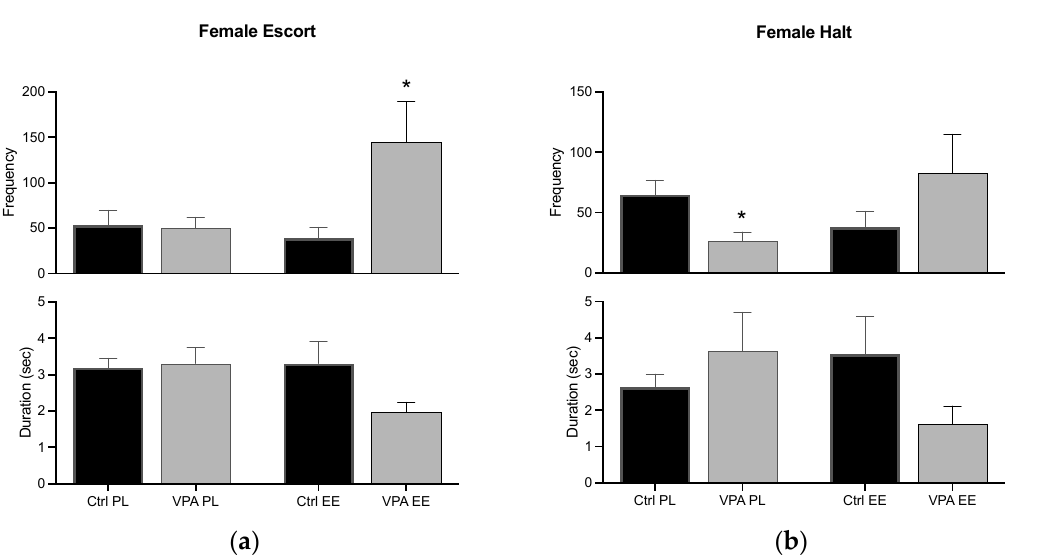
Figure 5. Female preconsummatory behaviors. The graph shows how many times the female escort ( a ) and halt ( b ) the male (frequency), and how long such behaviors were displayed for (duration). Data show the mean ± SEM. * = p < 0.05.